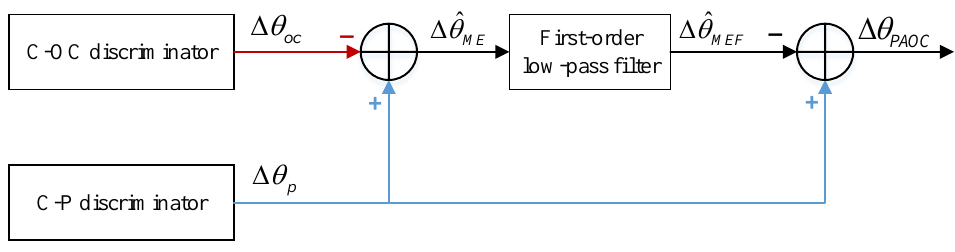
Figure 5. Schematic diagram of the PAOC technique for carrier multipath